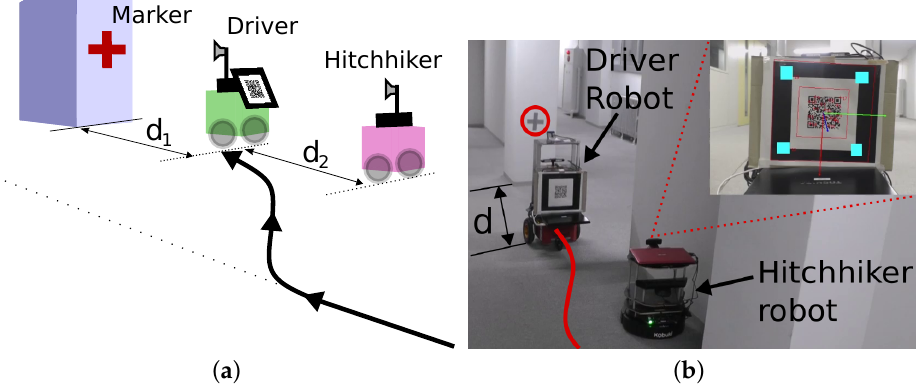
Figure 4. Benefit of hitchhiking area with markers. ( a ) Hitchhiker is stationary while the driver aligns with the marker; ( b ) Implementation result in real